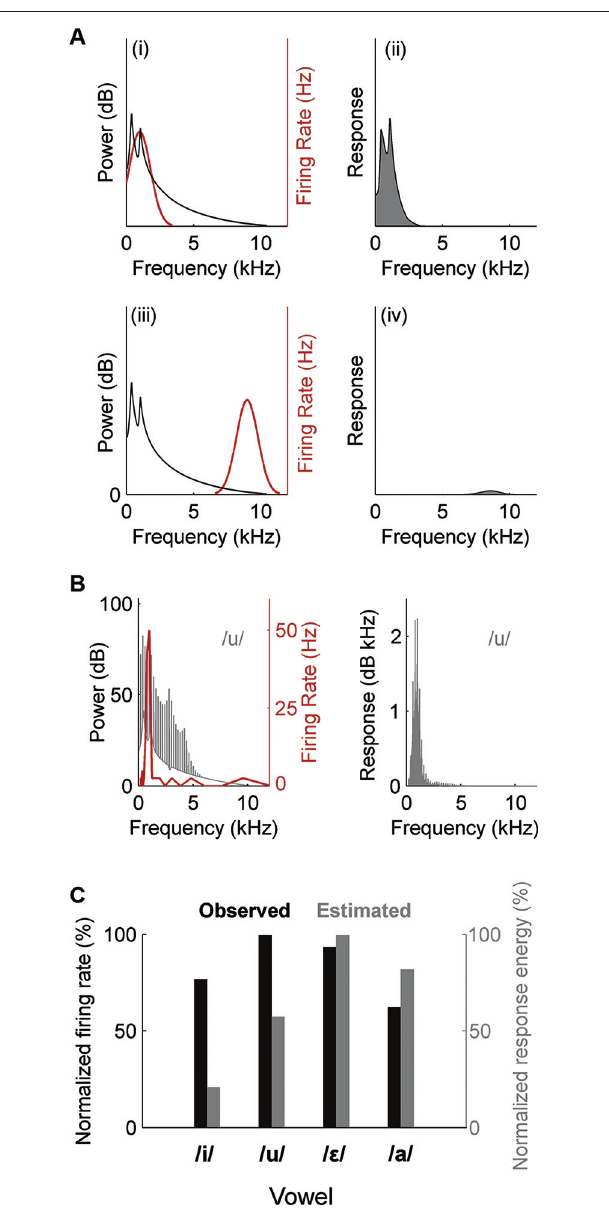
FIGURE 3 | Estimation of neural responses to vowels based on SRF . The power spectrum of a vowel is multiplied by the SRF of a neuron to produce an estimated response spectrum. The area under the spectrum is taken as the response energy; a measure of the neurons response magnitude. (A) When the vowel spectrum (black) and SRF (red) overlap (i), the neuron’s response energy is predicted to be large (ii). In contrast, if the vowel spectrum and SRF are separated (iii), the neuron’s response is predicted to be small (iv). (B) Left: SRF (red) recorded from a multi-unit cluster within auditory cortex of an anesthetized ferret and the spectrum of the vowel /u/. Right: Estimated response energy of unit to /u/. (C) Comparison of the estimated (grey) and observed (black) responses of the unit in (B) to a series of vowels. Firing rate and response energy are normalized for comparison. Note that the pattern of vowel discrimination by firing rate differs from the pattern estimated from response energy. Observed responses were measured as the mean firing rate across 20 presentations of each